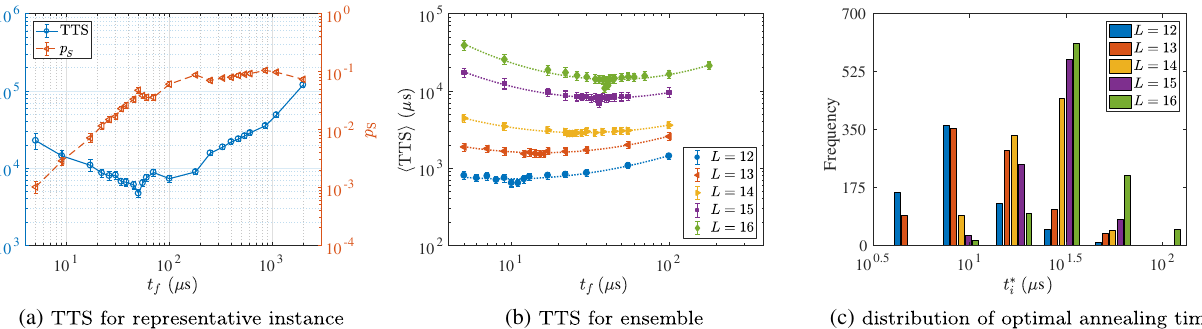
FIG. 1. Optimal annealing time and optimal TTS. Result shown are for the “ logical-planted ” instance class. (a) TTS (blue solid line) and p (red dashed line) for a representative problem instance at size L ¼ 16 . A clear minimum in the TTS is visible at t (cid:3) ¼ 50 μ s, thus S demonstrating the existence of an optimal annealing time for this particular instance (but not by itself for the problem class). Note that the decreasing or increasing TTS is associated with p growing sufficiently fast or too slowly, respectively, with increasing t . S f (b) Median TTS as a function of annealing time for L ≥ 12 , from 1000 instances. Dotted curves represent best-fit quadratic curves to the data (see Appendix G for the scaling of t (cid:3) with L , and Appendix K for details on the fitting procedure). The position of the minimum of these curves gives t (cid:3) . The position of h TTS i (cid:3) shifts to larger t as the system size increases. An optimum could not be established for f L < 12 for this instance class; i.e., it appears that t (cid:3) < 5 μ s when L < 12 . (c) The distribution of per-instance optimal annealing times t (cid:3) i for different system sizes, as inferred directly from the positions of the minima as shown in (a). It is evident that the number of instances with higher optimal annealing times increases along with the system size, in agreement with